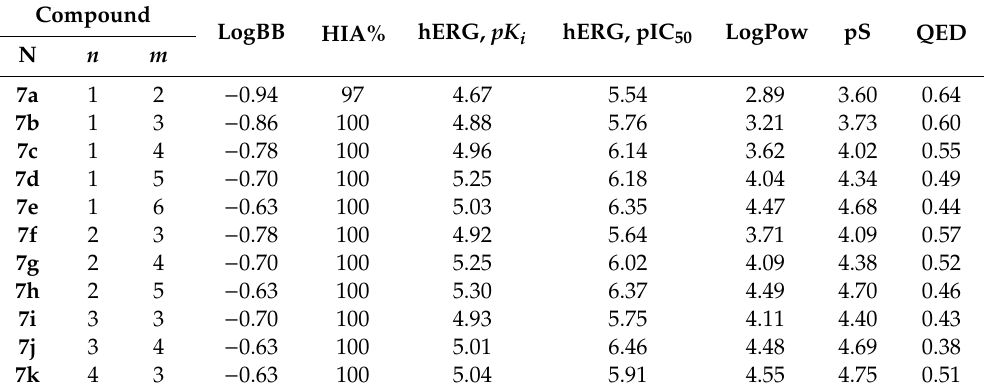
Table 2. Predicted ADMET and physicochemical profiles of conjugates 7